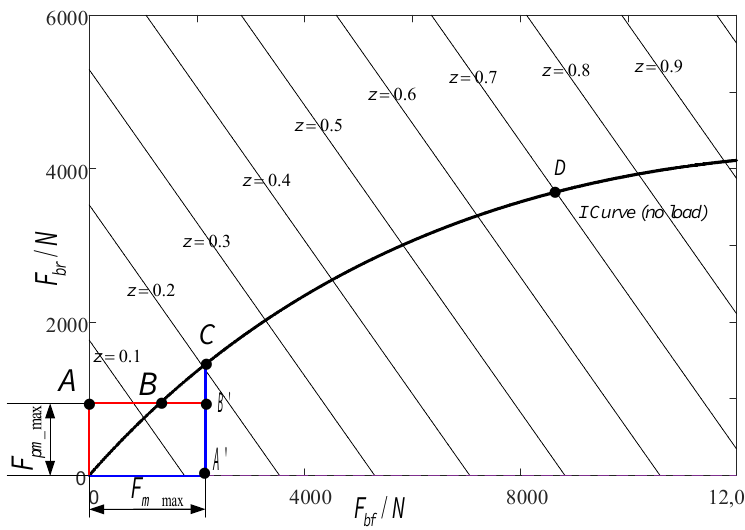
Figure 13. Braking force distribution curve of hybrid vehicles.